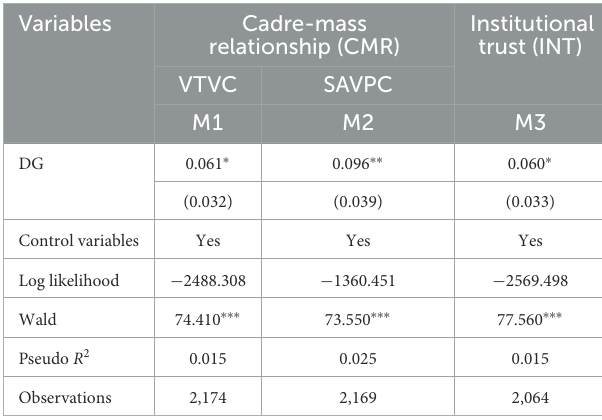
TABLE 5 Regression results for impact